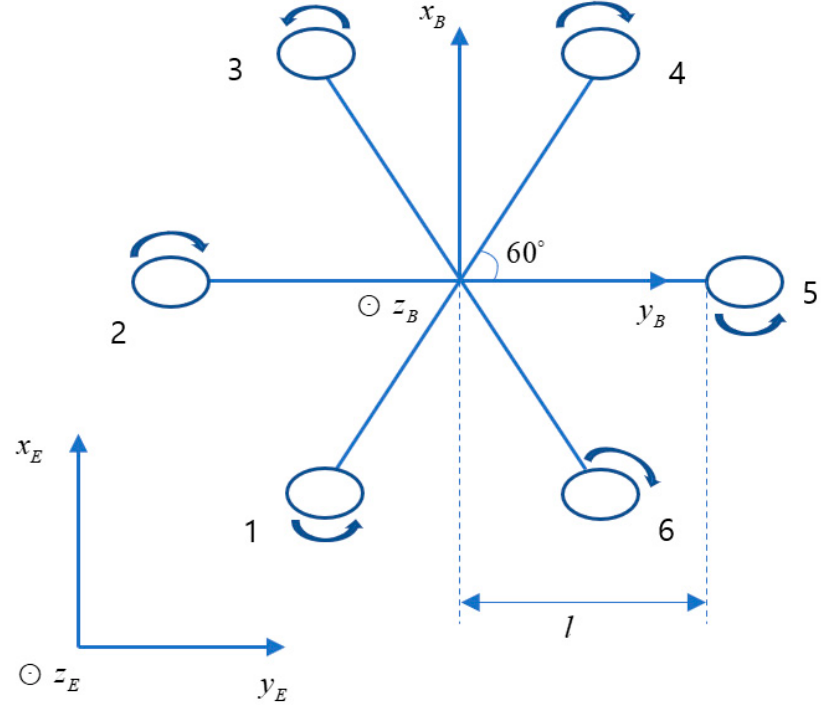
Figure 1. Hexacopter in body and inertial frames.